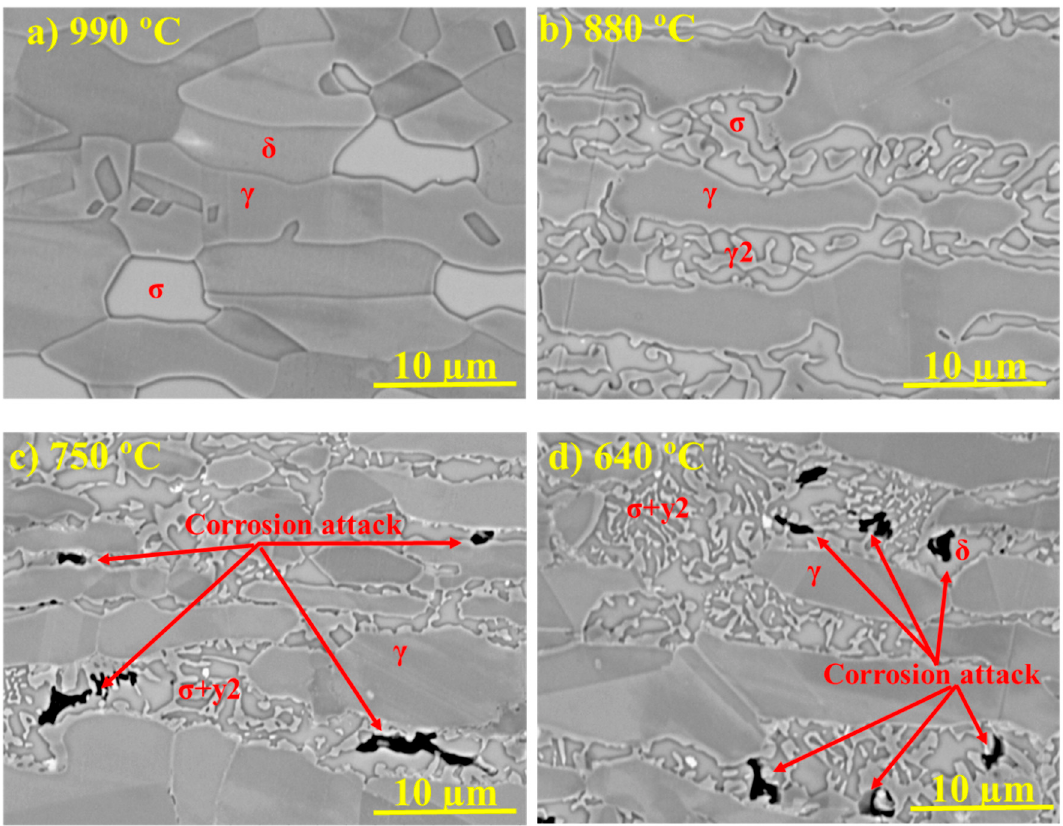
Figure 12. BSE SEM micrographs of SDSS after arc heat treatment at different aging temperatures and sensitization screening testing in oxalic acid: ( a ) 990 °C with very little sensitization, ( b ) 880 °C with some sensitization, and ( c ) 750 °C and ( d ) 640 °C with local corrosion attacks found in δ and/or γ 2 next to the coral-shaped σ .